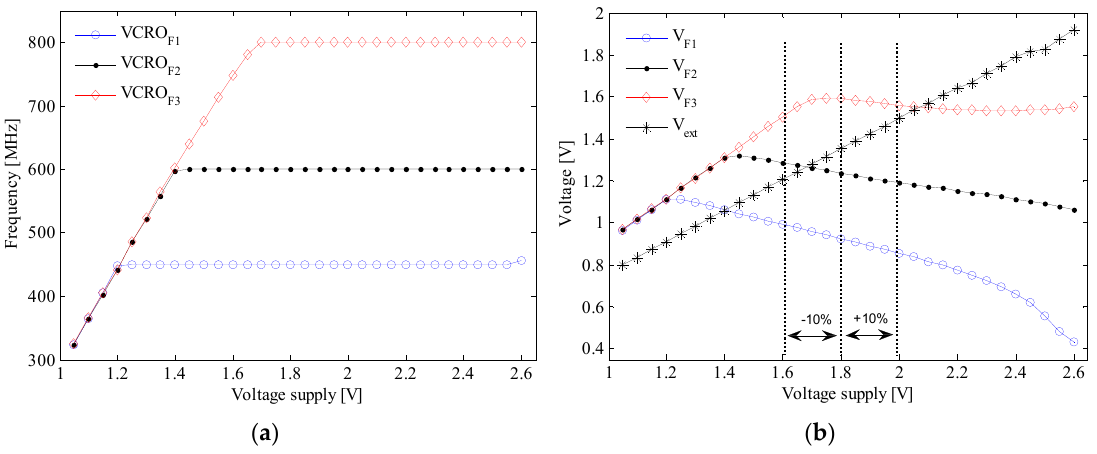
Figure 12. Measured synthesized frequencies’ dependence on the variation of VDD: ( a ) master VCRO output frequency and ( b ) loop filter voltage.